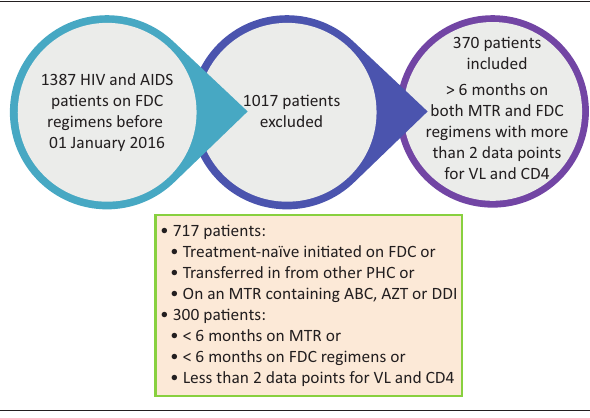
FIG URE 1: Selection of